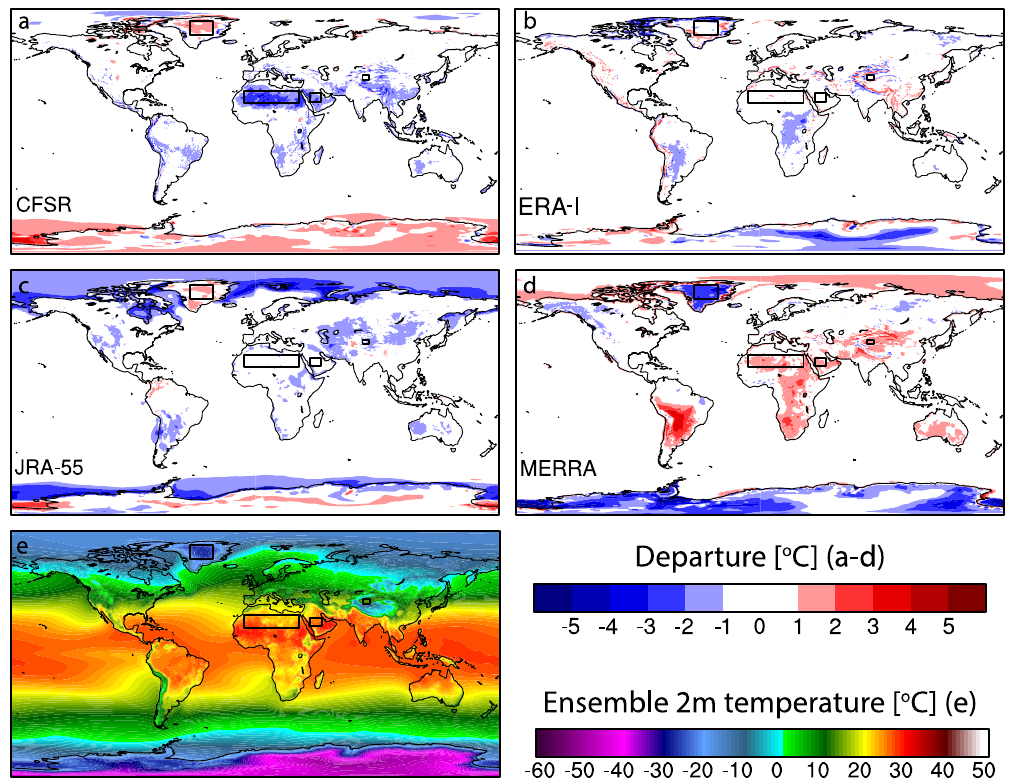
Figure 2. ( a – d ) Gridded differences in 2-m air temperature for each reanalysis model subtract ( e ) the ensemble mean 2-m air temperature over the 1981–2010 period. Black boxes show locations for annual average time series in Figure 3.